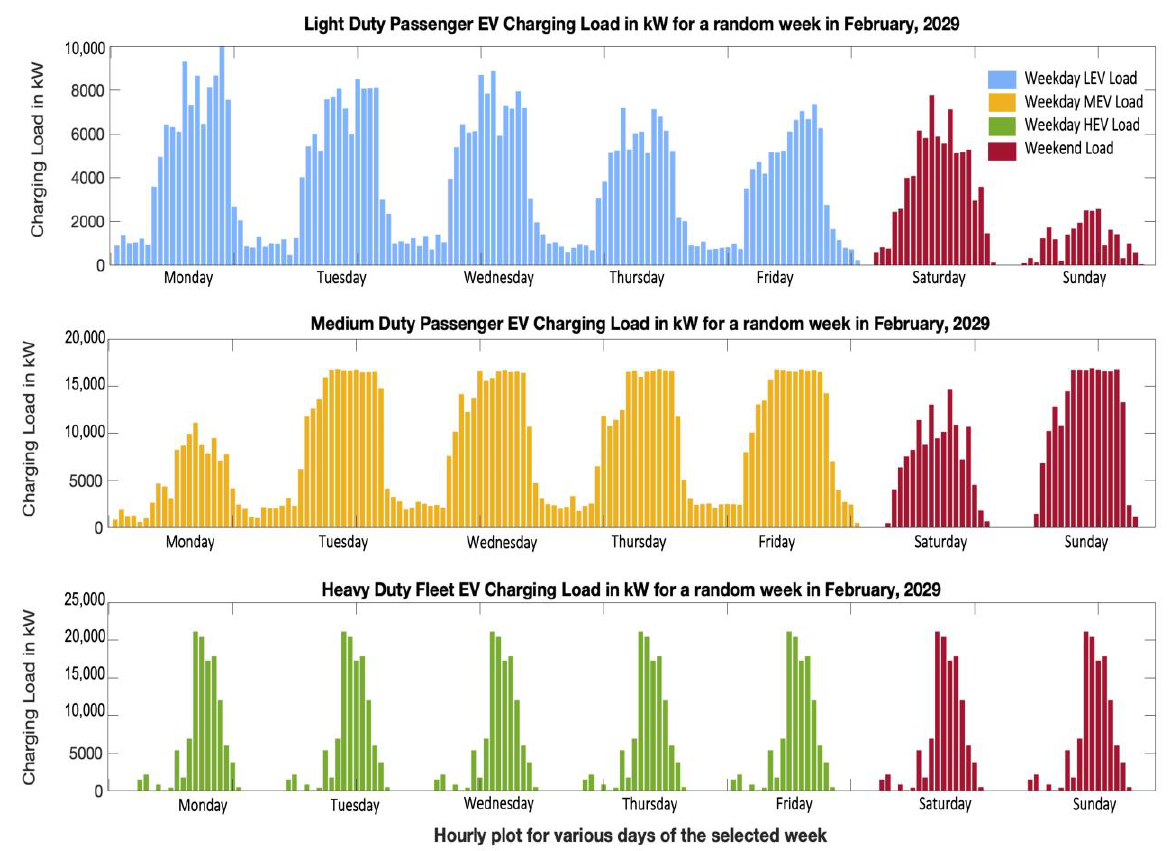
Figure 7. Modelled charging load profiles for light-duty passenger EVs (LEV), medium-duty passenger EVs (MEV), and heavy-duty truck fleet EVs (HEV) for a random week in February 2029.